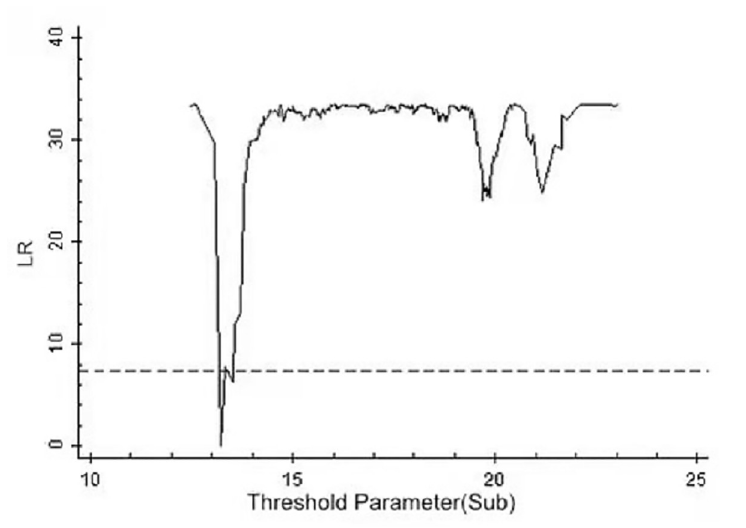
Fig 3. Estimated value and confidence interval of the first threshold in Model 2.